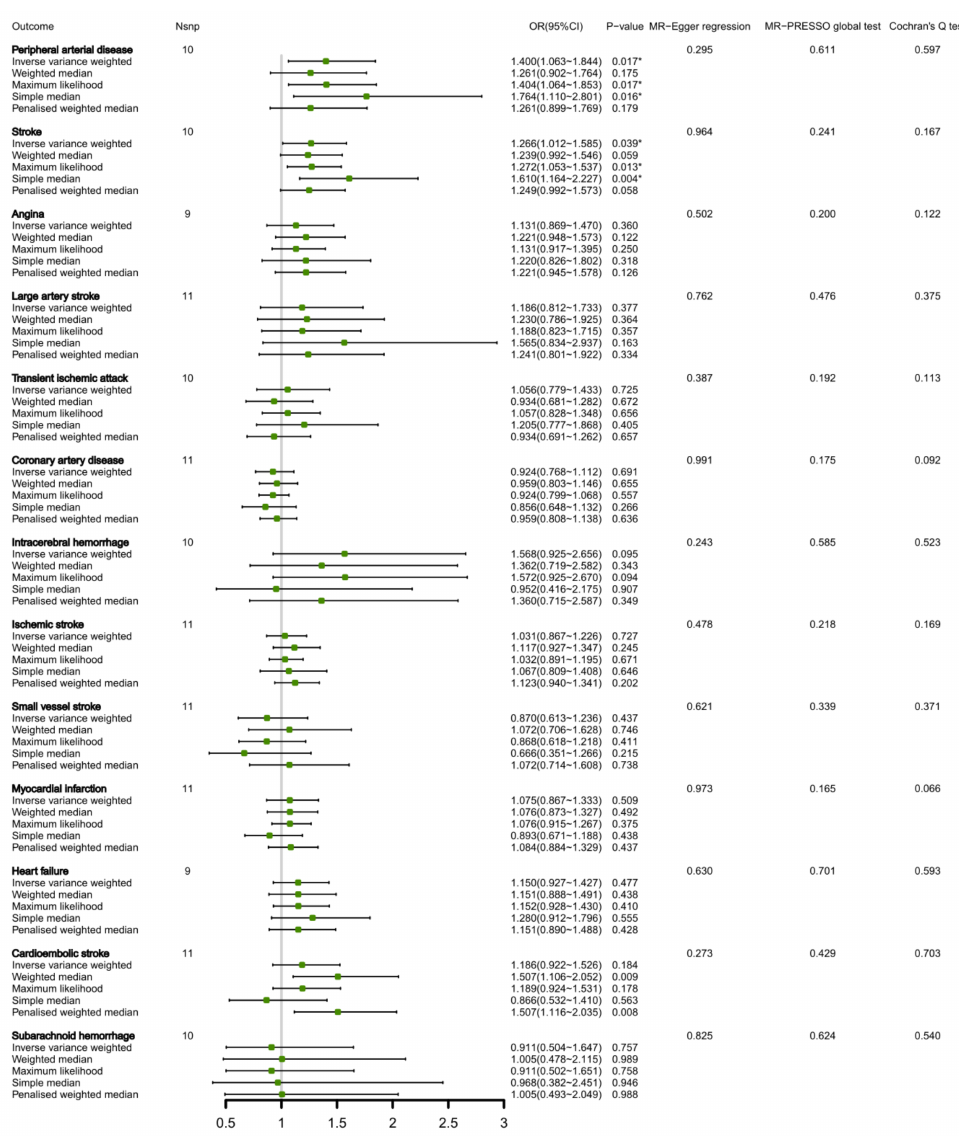
Figure 1. MR estimates the associations between circulating total BCAA levels and CVDs. * Indicates p < 0.05. Nsnp, number of